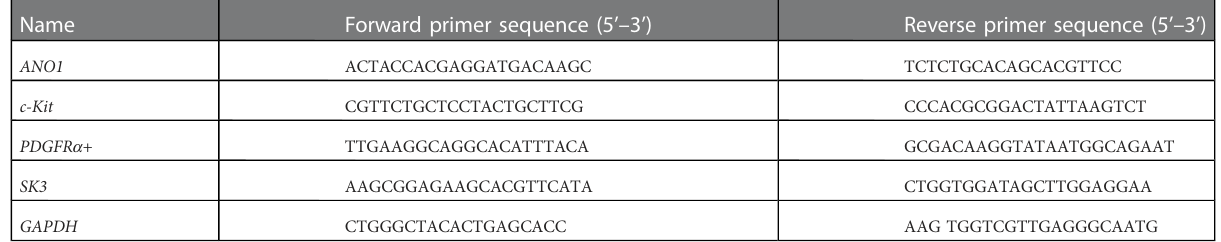
TABLE 2 Gene primer